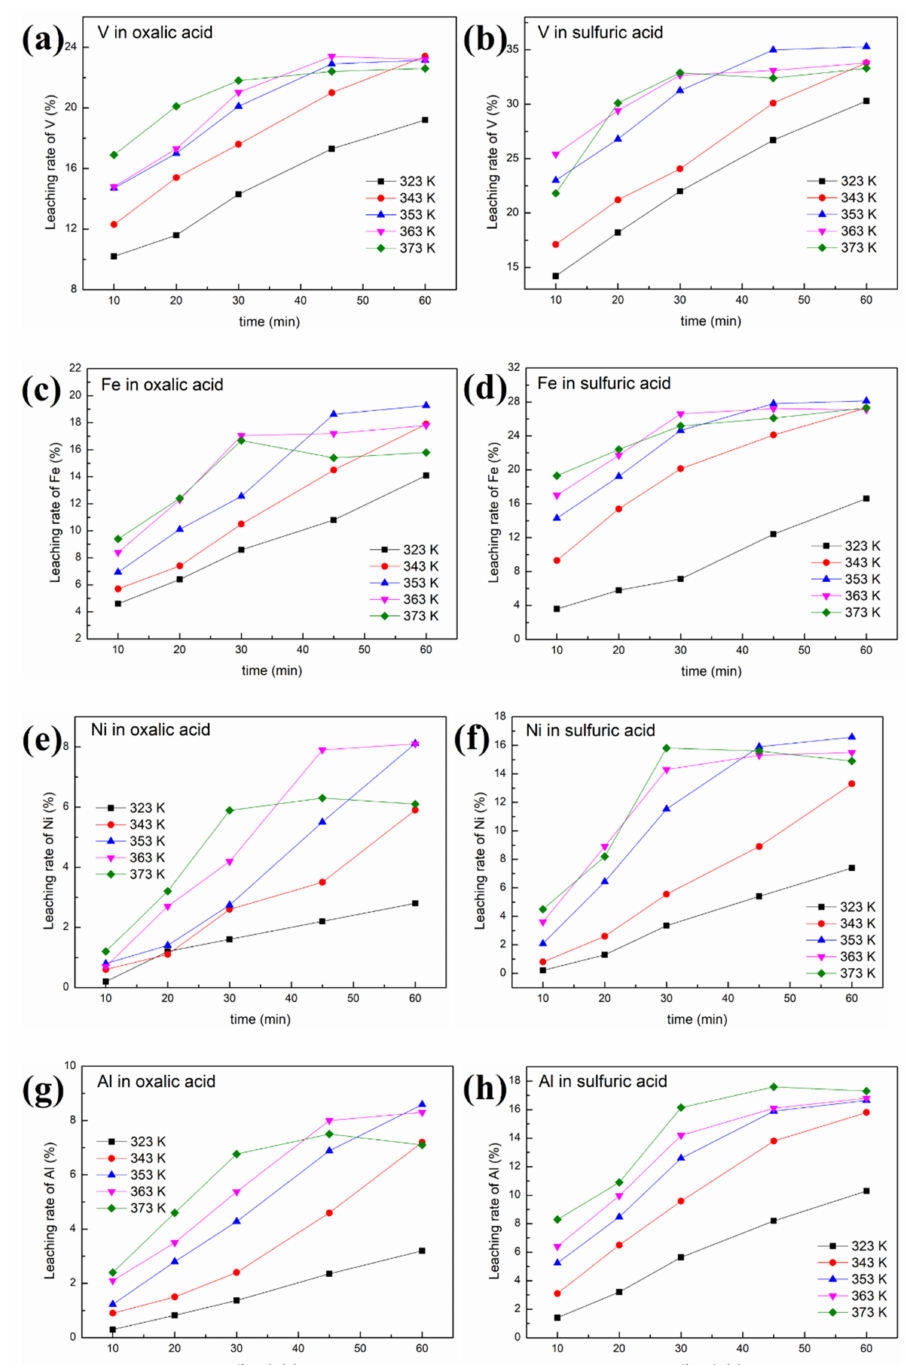
Figure 6. Effect of leaching temperature and time on the removal of contaminant metals from the SFCC catalyst: ( a ) leaching rate of V in oxalic acid; ( b ) leaching rate of V in sulfuric acid; ( c ) leaching rate of Fe in oxalic acid; ( d ) leaching rate of Fe in sulfuric acid; ( e ) leaching rate of Ni in oxalic acid; ( f ) leaching rate of Ni in sulfuric acid;( g ) leaching rate of Al in oxalic acid; ( h ) leaching rate of Al in sulfuric acid (4 g SFCC catalyst, 0.5 mol/L acid concentration, S/L = 1:10, 400 W, 2450 MHz, 2 kg/cm 2